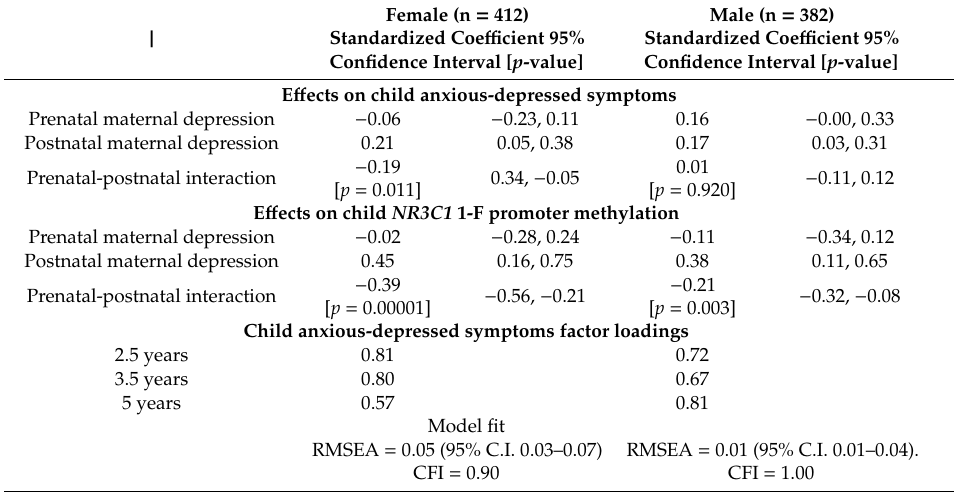
Table 2. Summary of SEM analyses predicting NR3C1 1-F promoter methylation and child anxious-depressed